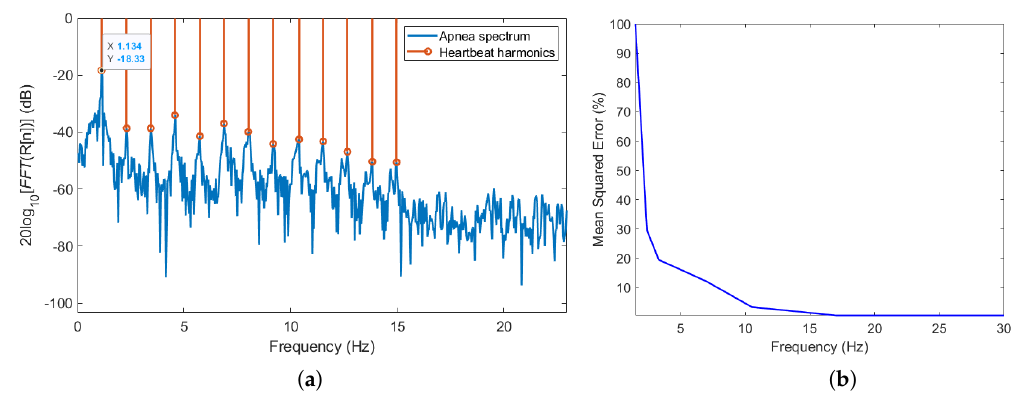
Figure 9. ( a ) Spectrum of a measurement in apnea conditions and the harmonics passing through the filter. ( b ) MSE expressed in % of the reconstructed heartbeat signal varying the filter cut-off frequency, f c = k 2 · f hb . k 2 is the number of harmonics passing through the filter bandwidth and f hb is the fundamental heartbeat